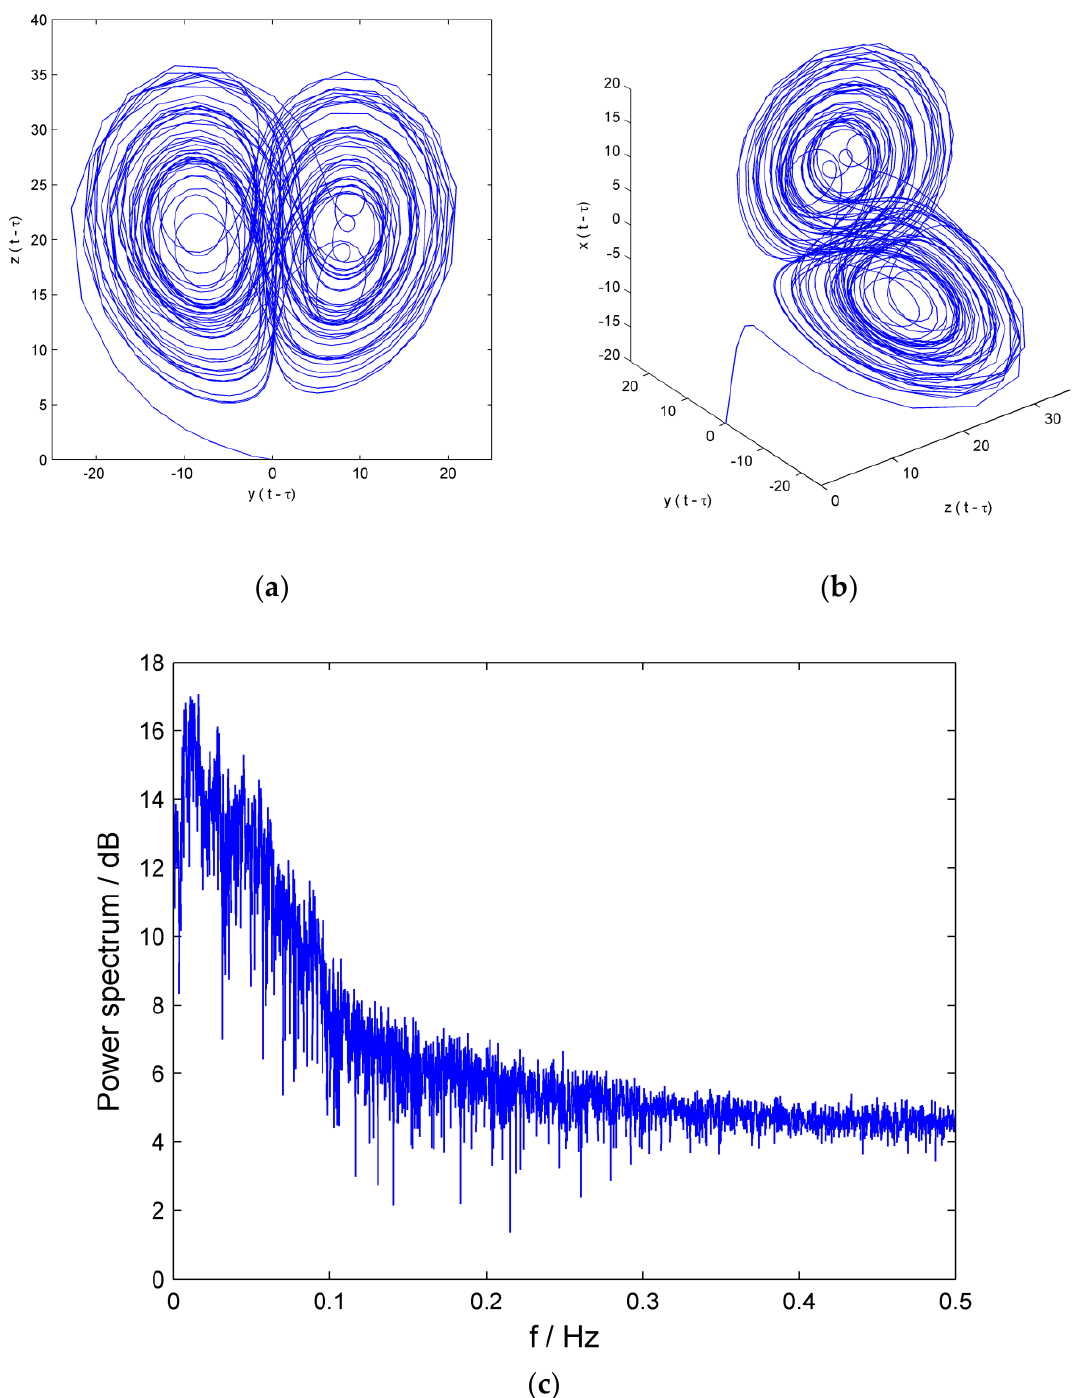
Figure 4. Phase diagram of a time-delay four-dimensional Lorenz chaotic attractor. ( a ) x-z plane phase diagram; ( b ) x-y-z plane phase diagram; ( c ) the power spectrum of the variable x ( t ). The sensitivity of the initial values is one of the most important properties of chaos, which makes long-term prediction of the system impossible. Figure 5 shows the time domain waveform of the initial function x ( t ) of the chaotic time-delay model combined with the difference between the 10 − 8 disturbance and the original series as a function of time t